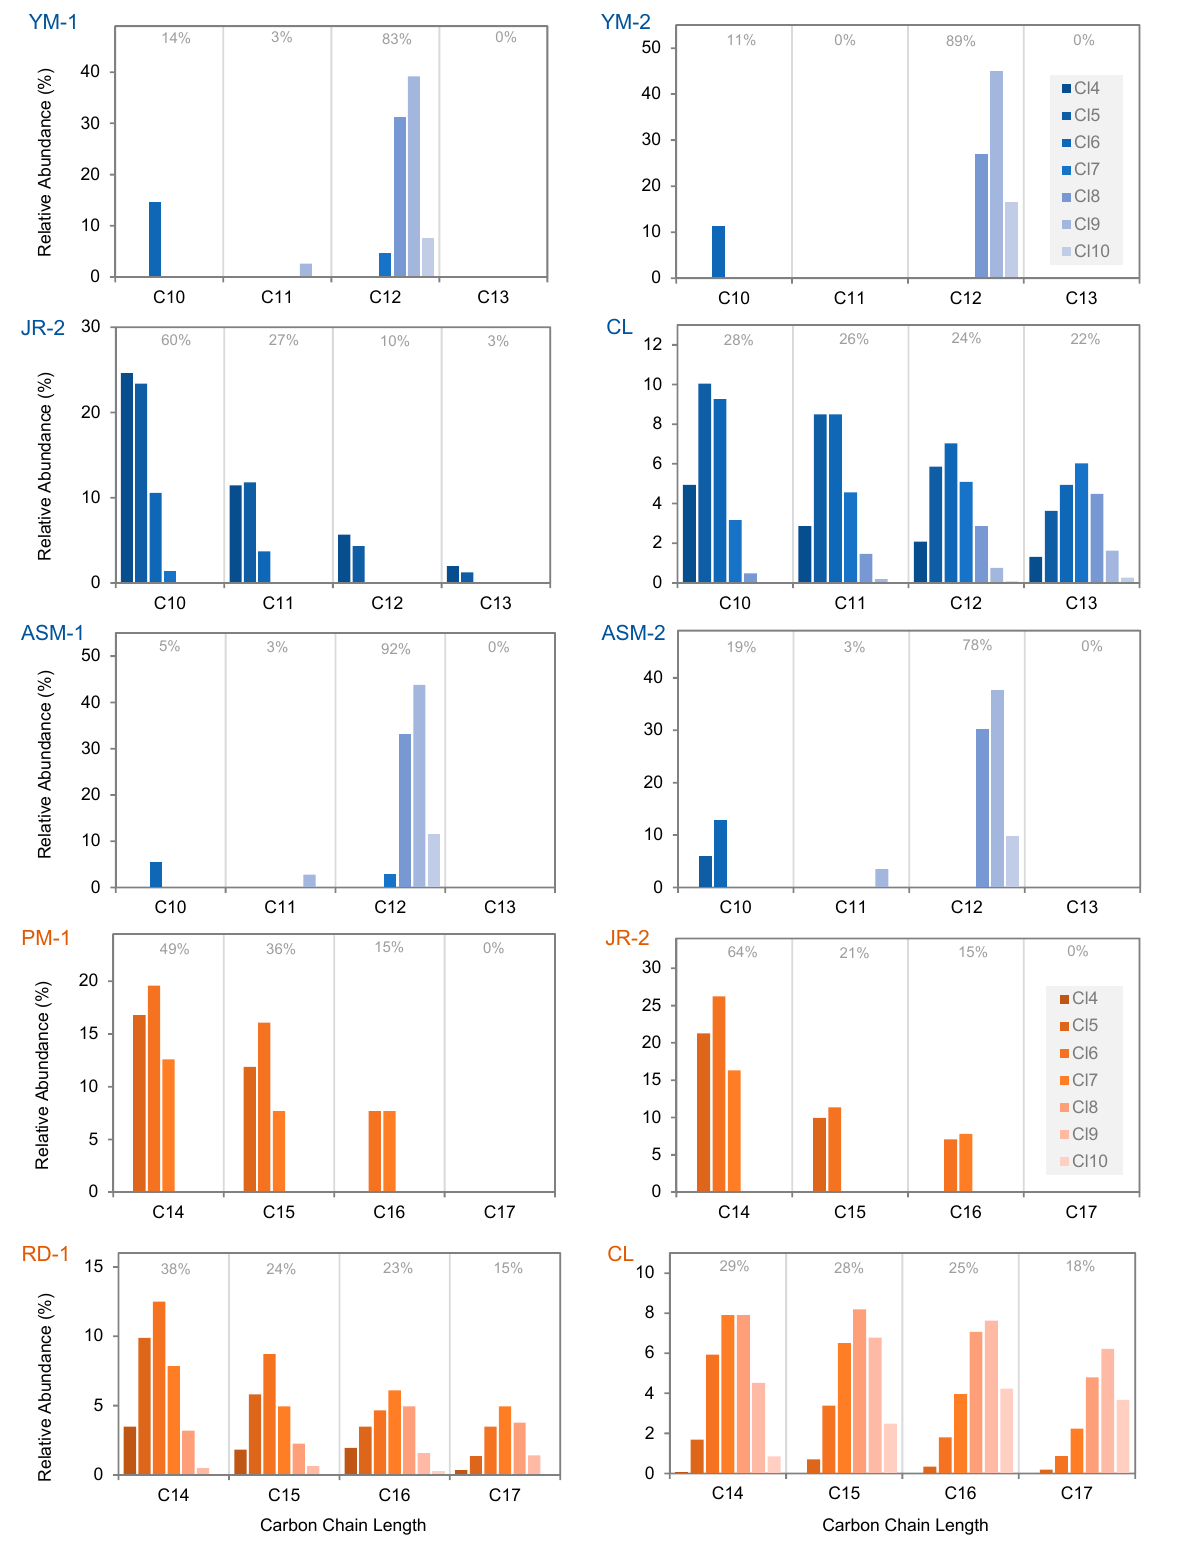
Figure 1. Relative abundance (%) of congener group patterns in the consumer product and toy samples with ∑ SCCP (blue) or ∑ MCCP (orange) concentrations >10 µg/g. Relative abundance (%) for summed homologues per carbon-chain length is shown above respective carbon-chain length groups.